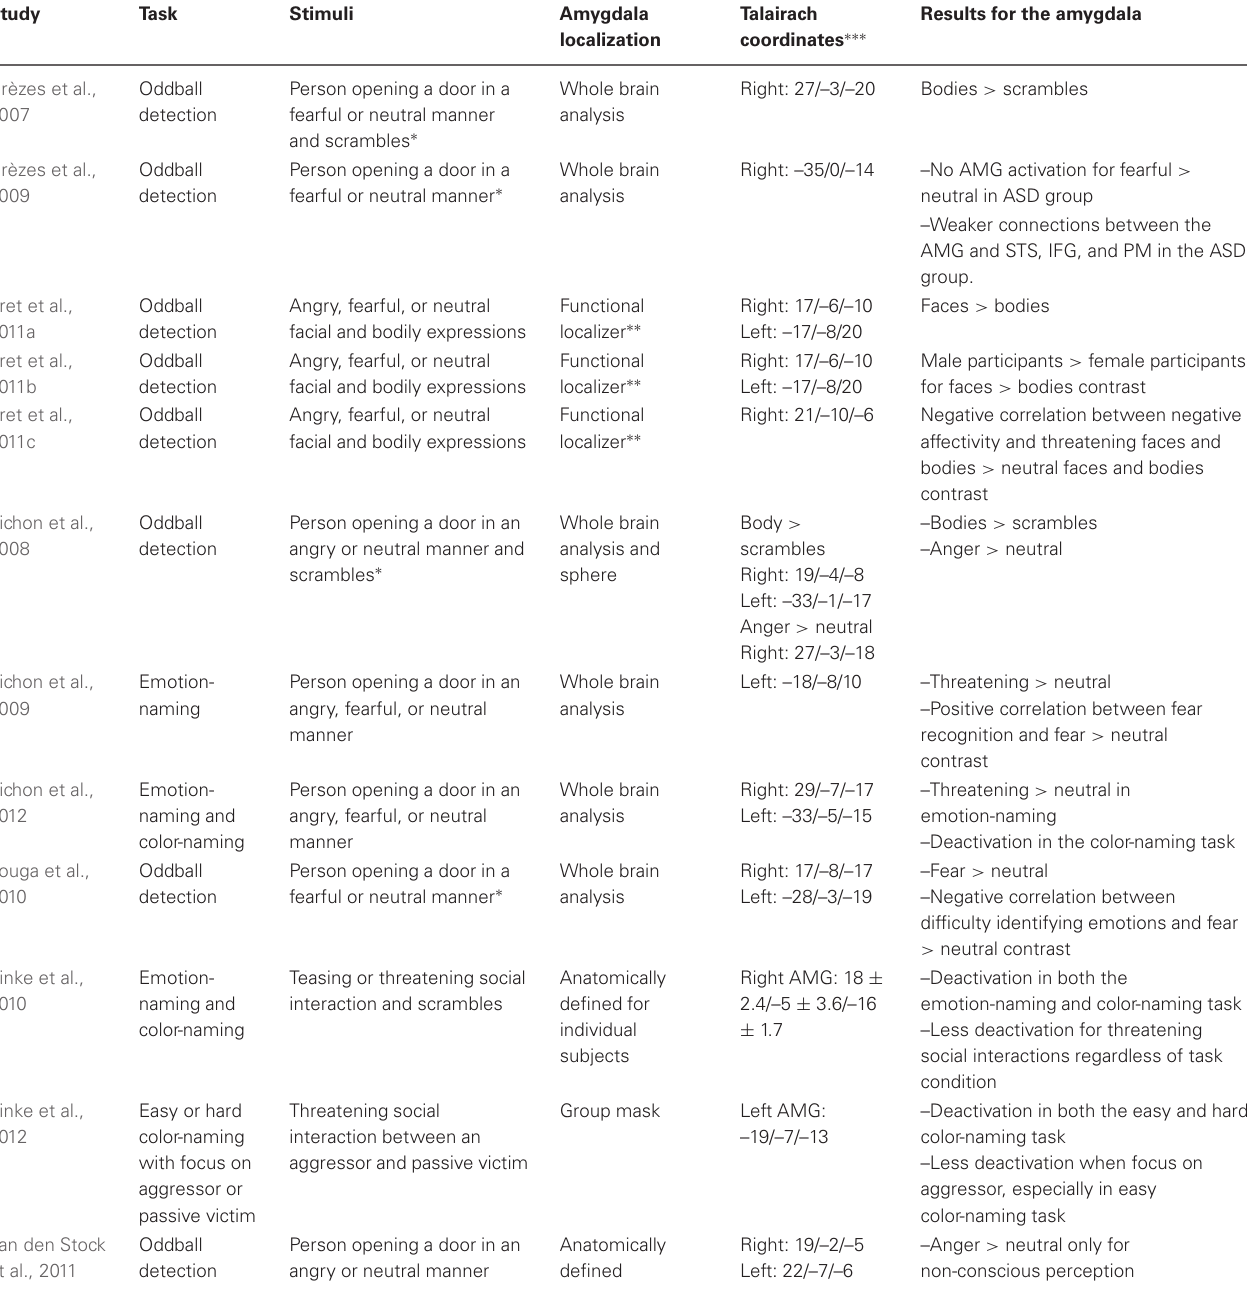
Table 1 | Overview of discussed studies using dynamic bodily